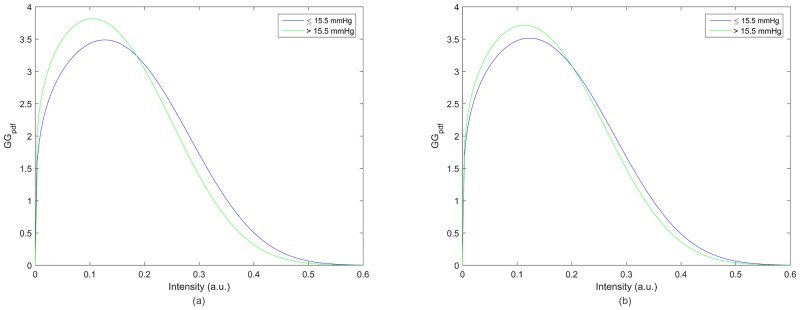
Probability density function of the Generalised Gamma distribution considering two averaged IOP groups for non-corrected (a) and corrected (b) IOP measurements.